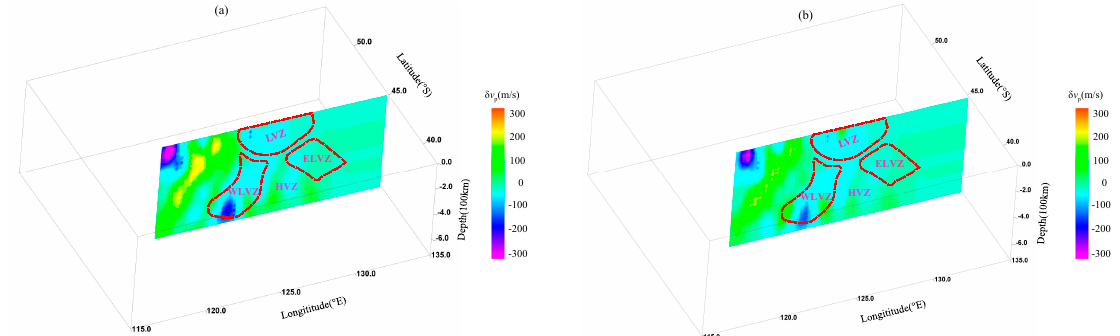
Figure 14. Section results of the study area, ( a ) 45 ◦ N; ( b ) 44.5 ◦ N.